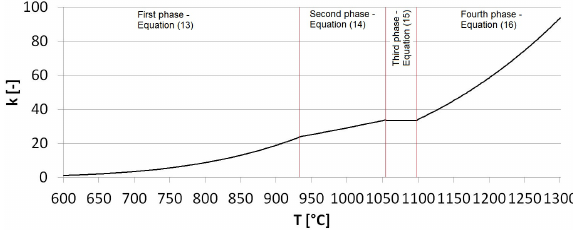
Figure 5. Development of the parameter k with temperature as defined by